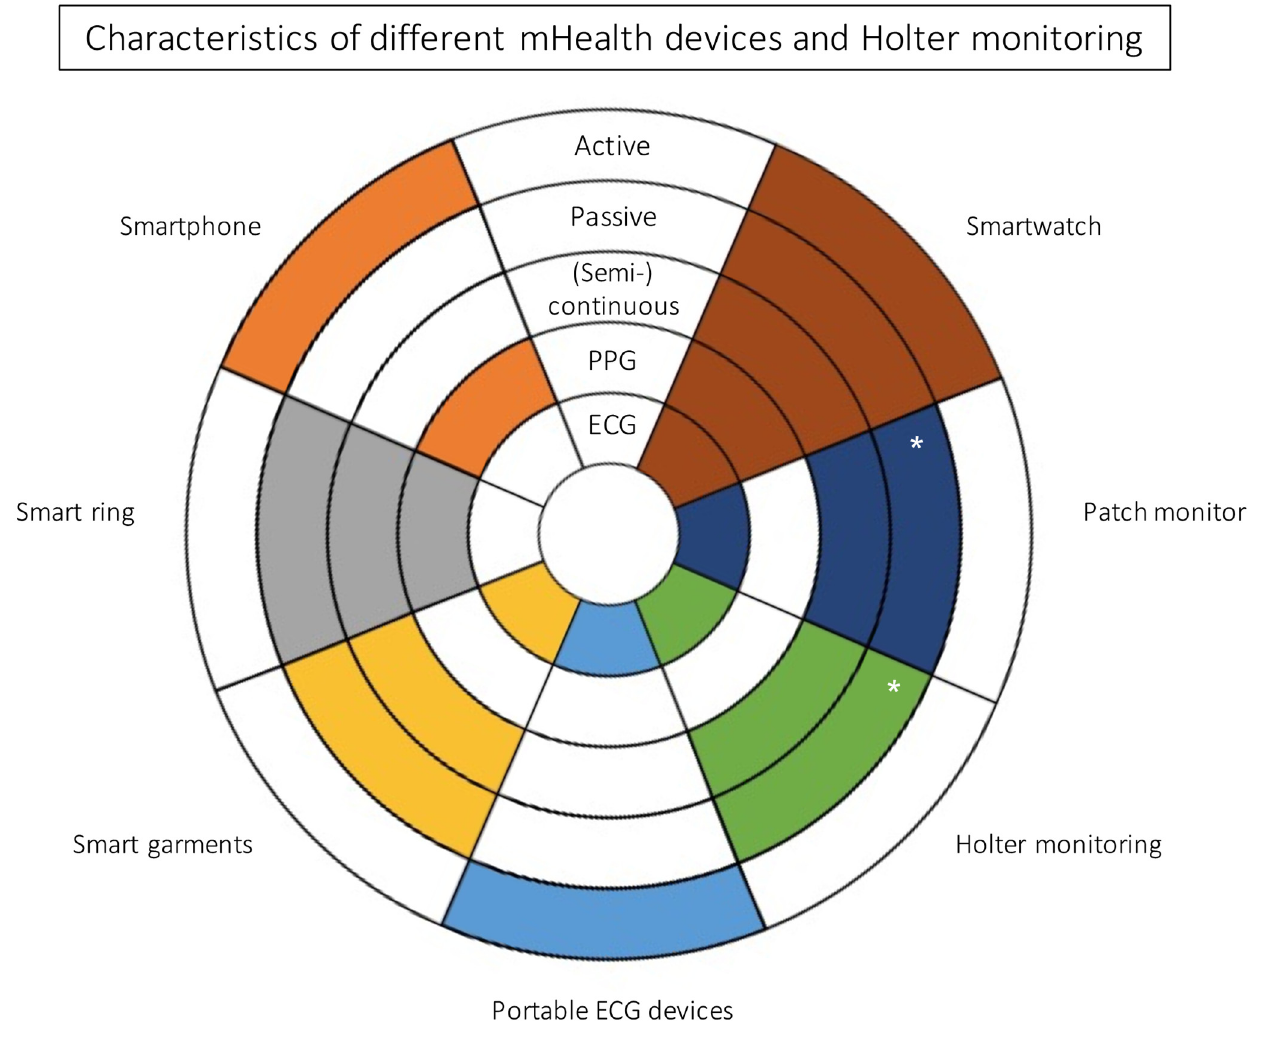
Figure 1. Characteristics of different mHealth devices and Holter monitoring. Colored fields signify that the wearable has the capability described. “Active” regards to the patients’ possibility of manually record an episode, whereas “passive” refers to monitoring via automatically recorded episodes using the individual device. A (semi-)continuous tracking describes the ability of the device to monitor patients’ heart rhythm via automatic pre-set intervals. PPG = photoplethysmography; ECG = electrocardiogram; * for a limited time.